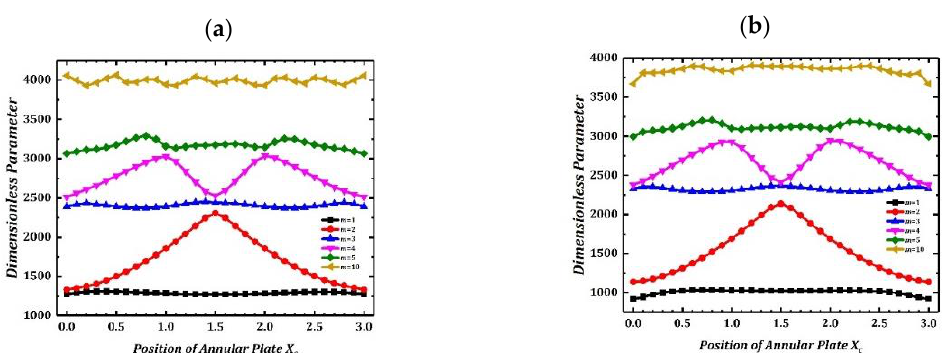
Figure 3. Variation of frequency parameters of LCDCSS with various coupling positions. ( a ) CC-CC; ( b ) SS-SS.